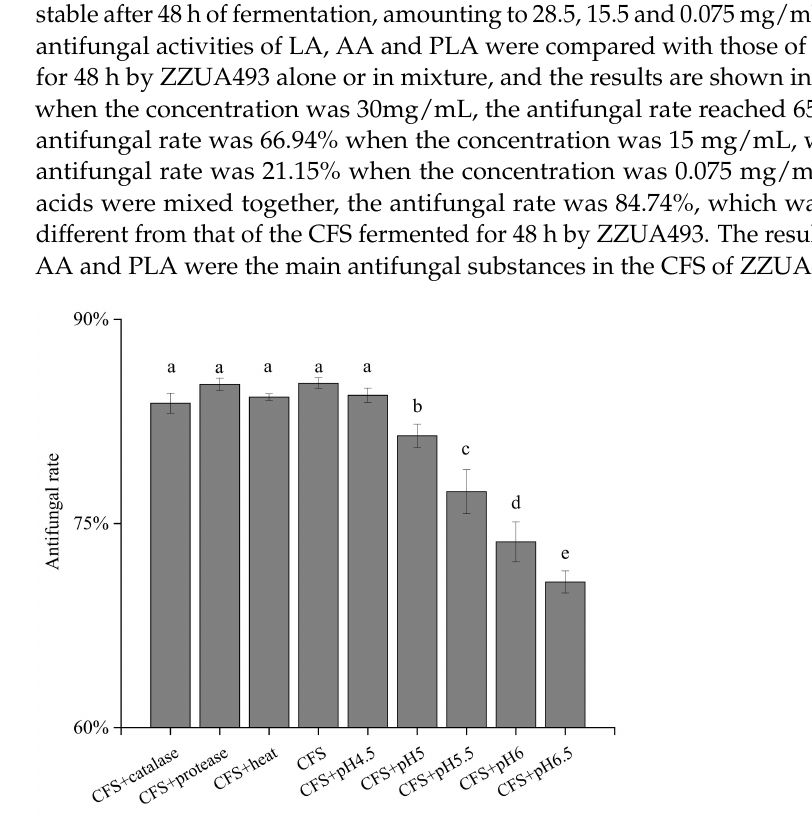
Figure 5. The antifungal rate of CFS after different treatments in 96-well microtiter plate method. Values with different superscript lowercase letters show significant differences among treatments ( p < 0.05). CFS, cell-free supernatant.